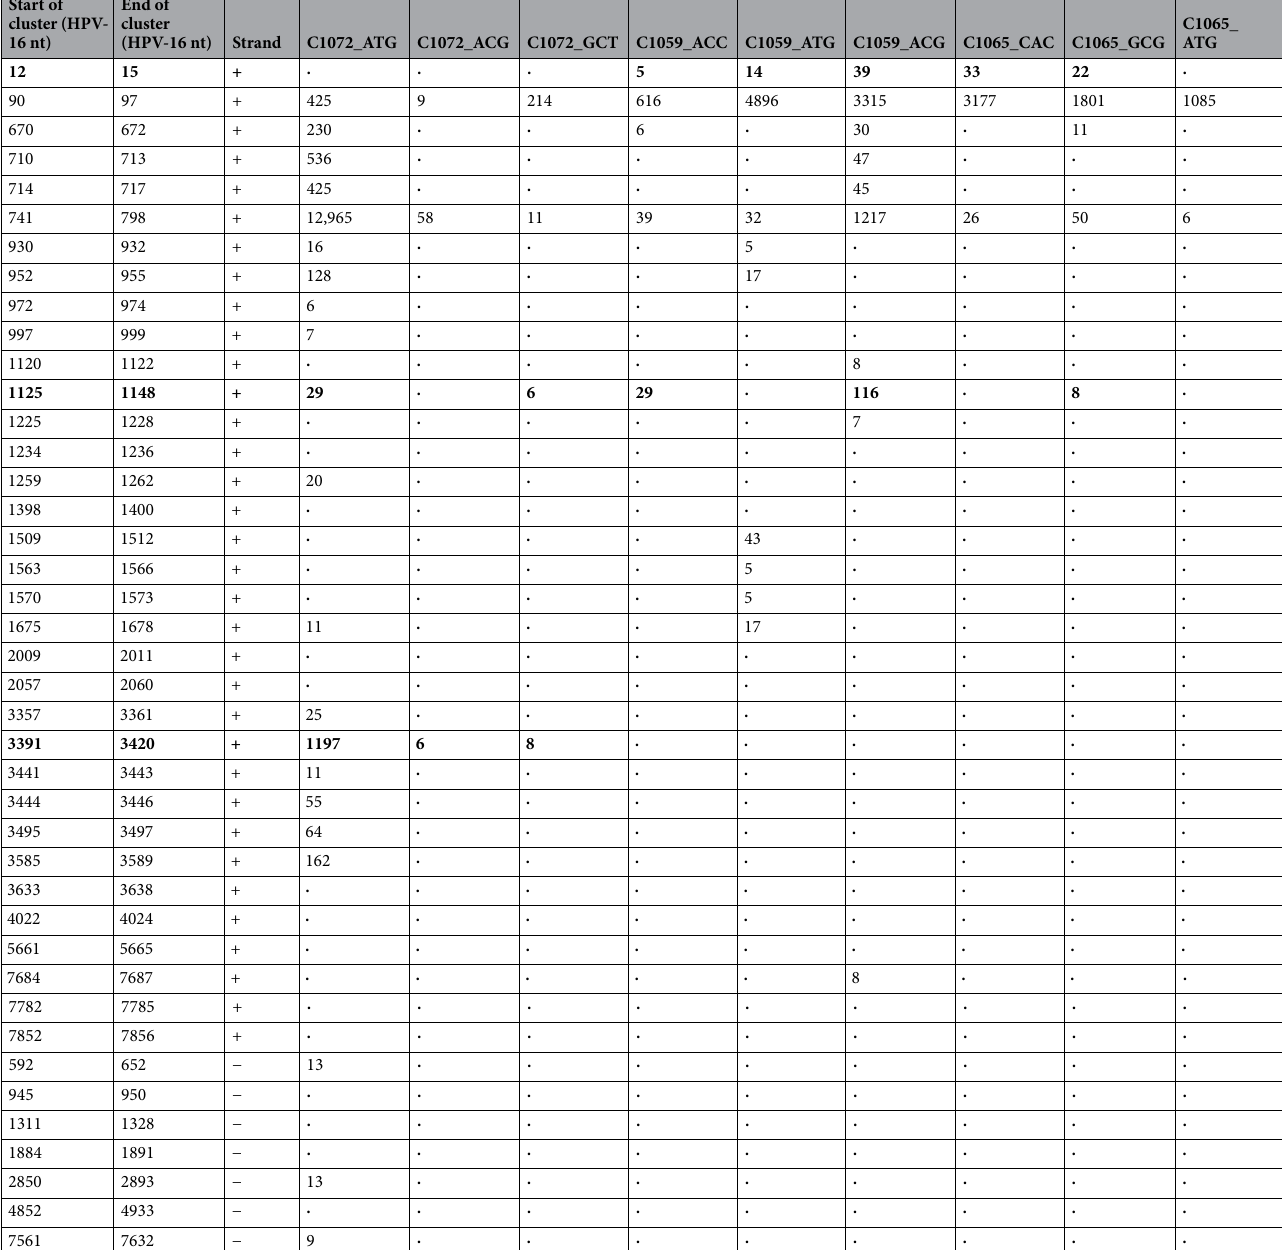
Table 2. Summary of the HPV-16-derived tag numbers of cervical samples by nAnTi-CAGE. CAGE tag 5 ′ -coordinates were used for Paraclu clustering with the following parameters: (i) minimum five tags per cluster; (ii) (maximum density/baseline density) ≥ 2; and (iii) 100-bp maximum cluster length. Tag numbers < five were designated as negative for each TSS cluster. nt12-15, nt1125-1148, and nt3391-3420 are highlighted in bold. “ · ” indicates negative for each TSS cluster (tag numbers <